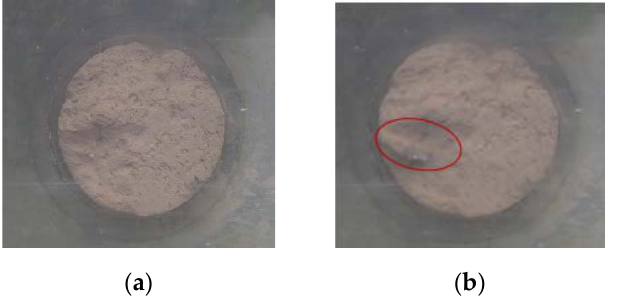
Figure 8. Continually lifted soil. ( a ) The soil is continually carried away by the flow ( b ) The soil is lifted.